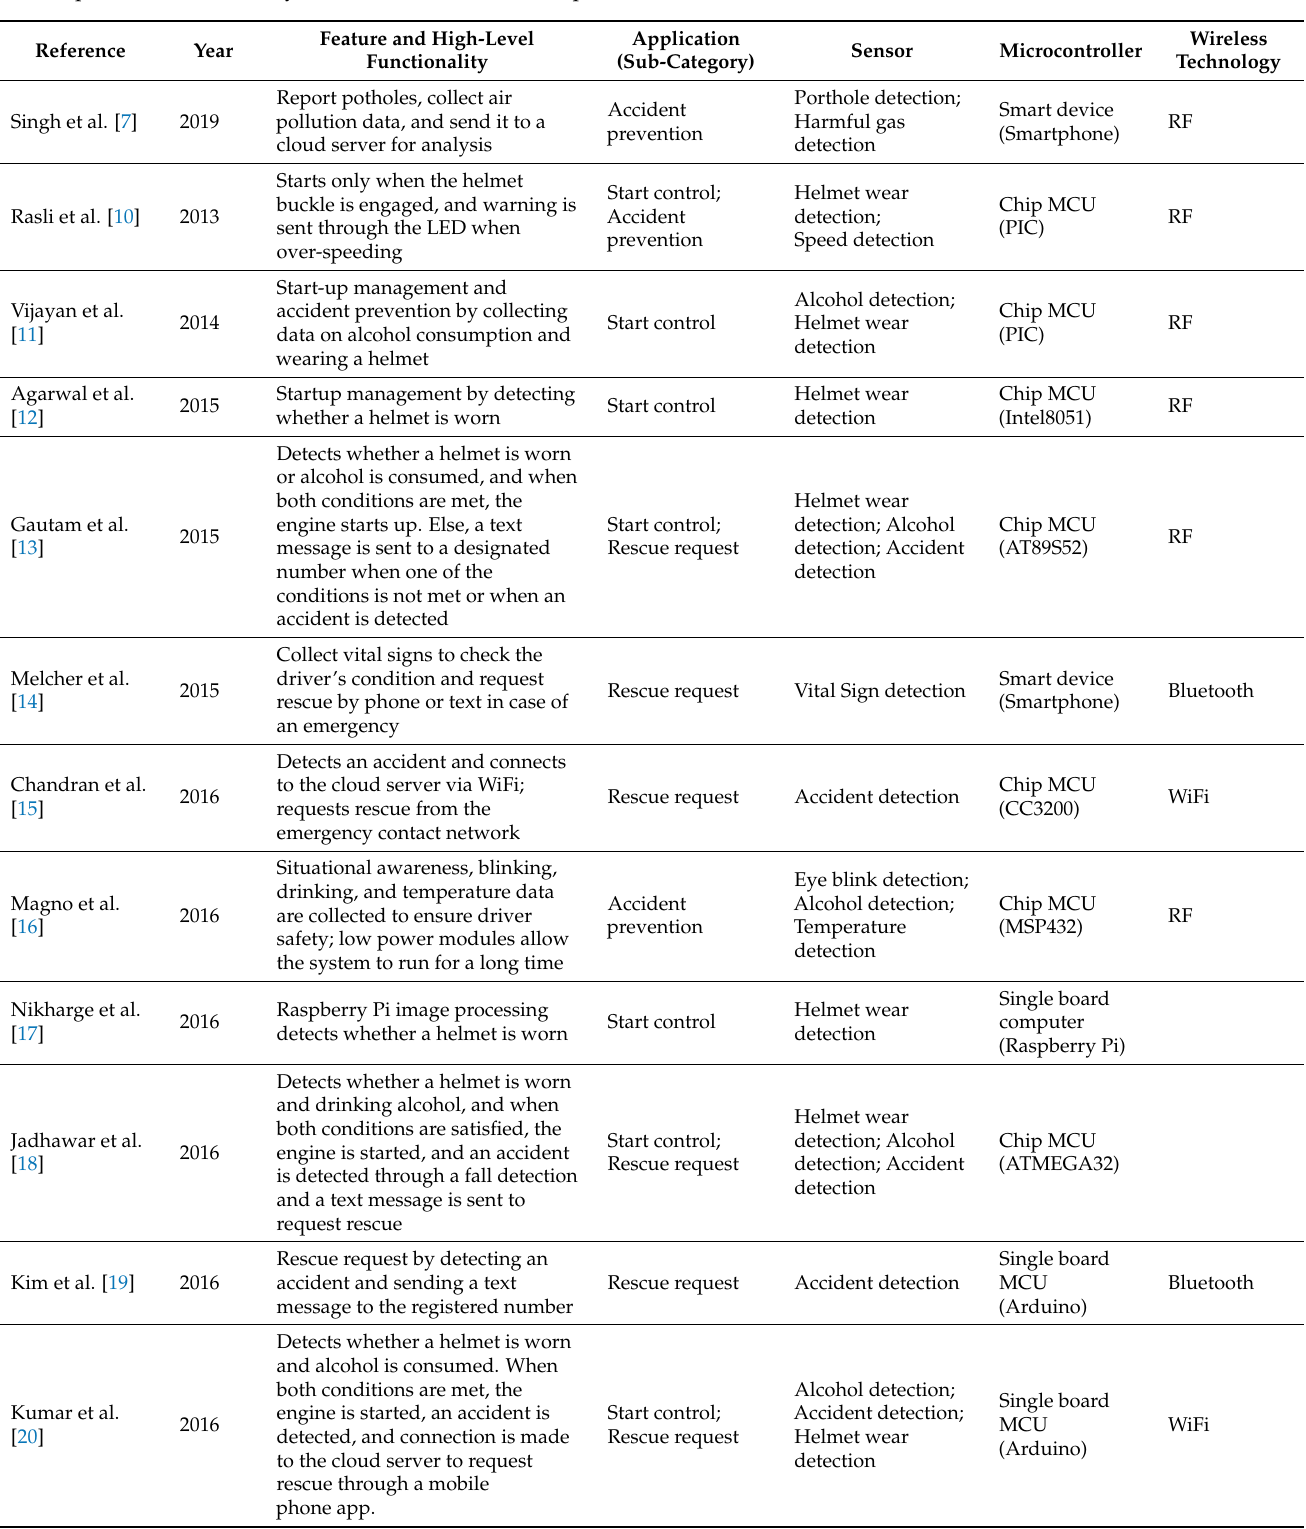
Table 2. Summary of smart helmet applications for start control, accident prevention, rescue request, and convenience improvement of motorcyclists (MCU: modular concept